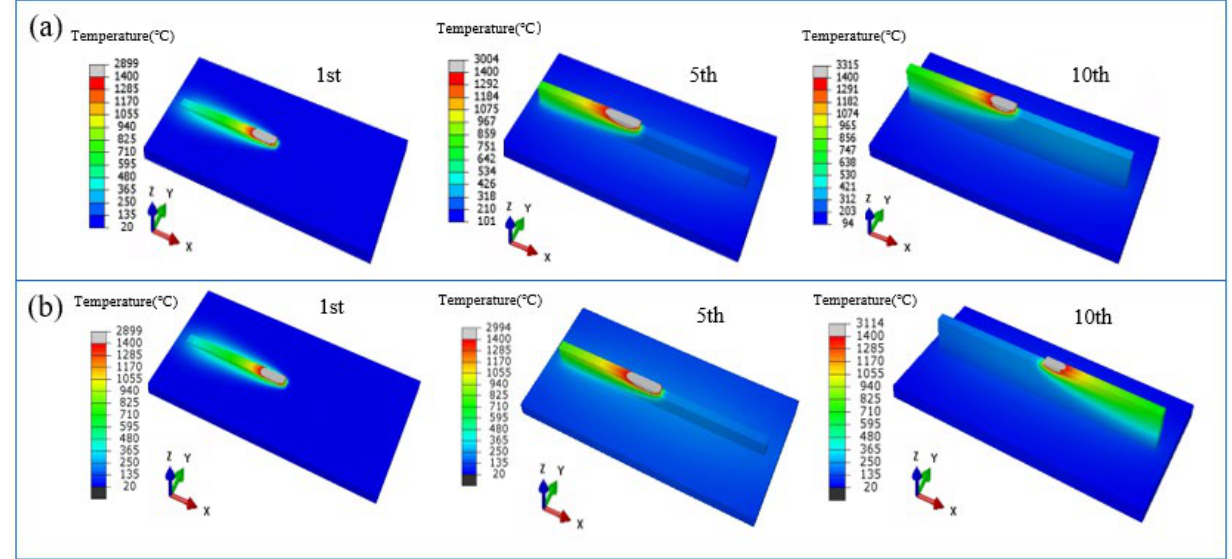
Figure 9. Temperature field distribution at different midpoints for different paths. ( a ) SMD scan path. ( b ) RM scan